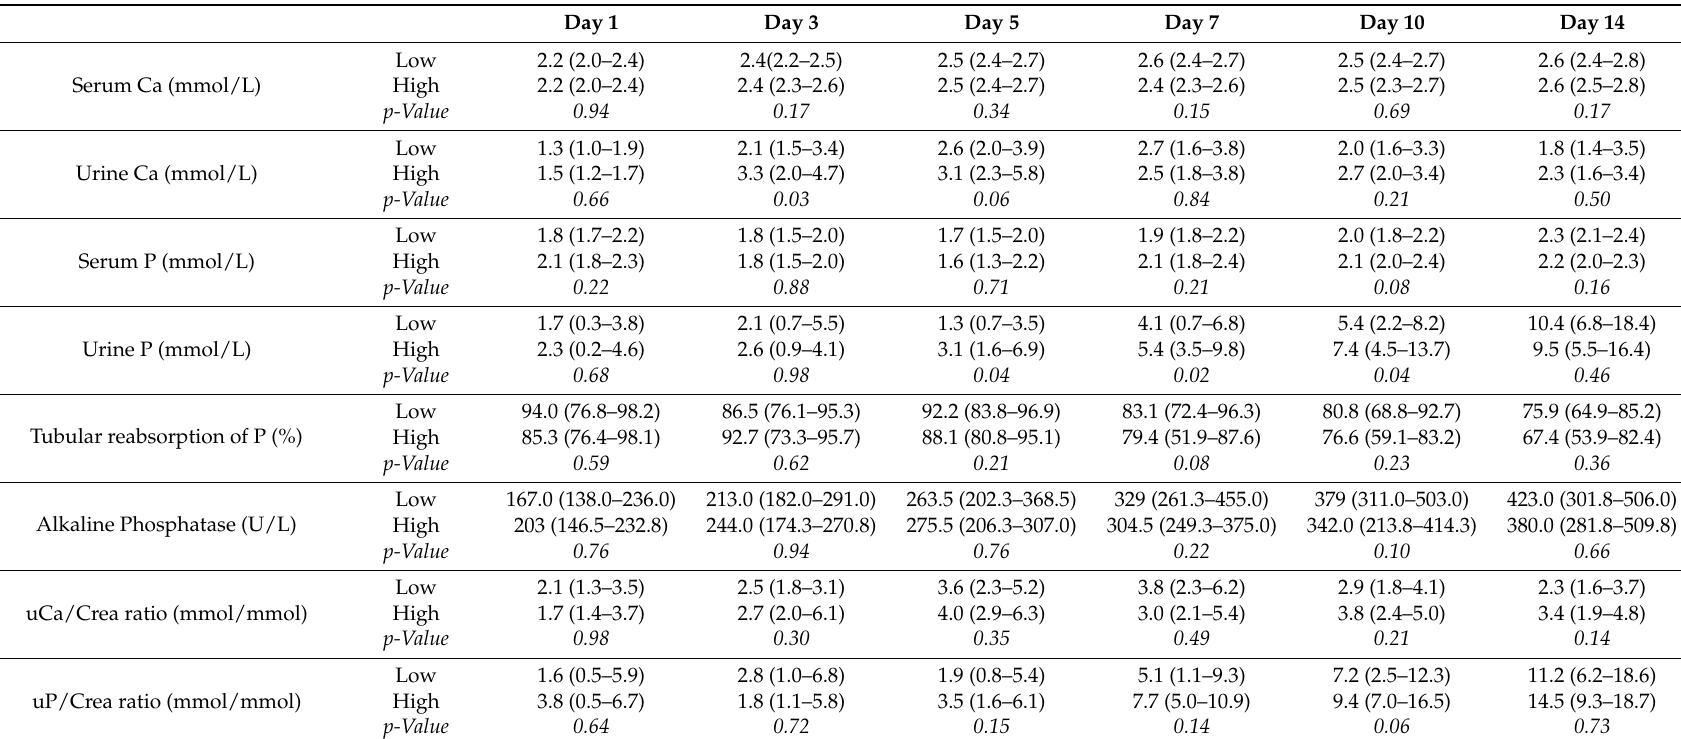
Table A4. Daily measurements of biochemical parameter of the calcium and phosphorus